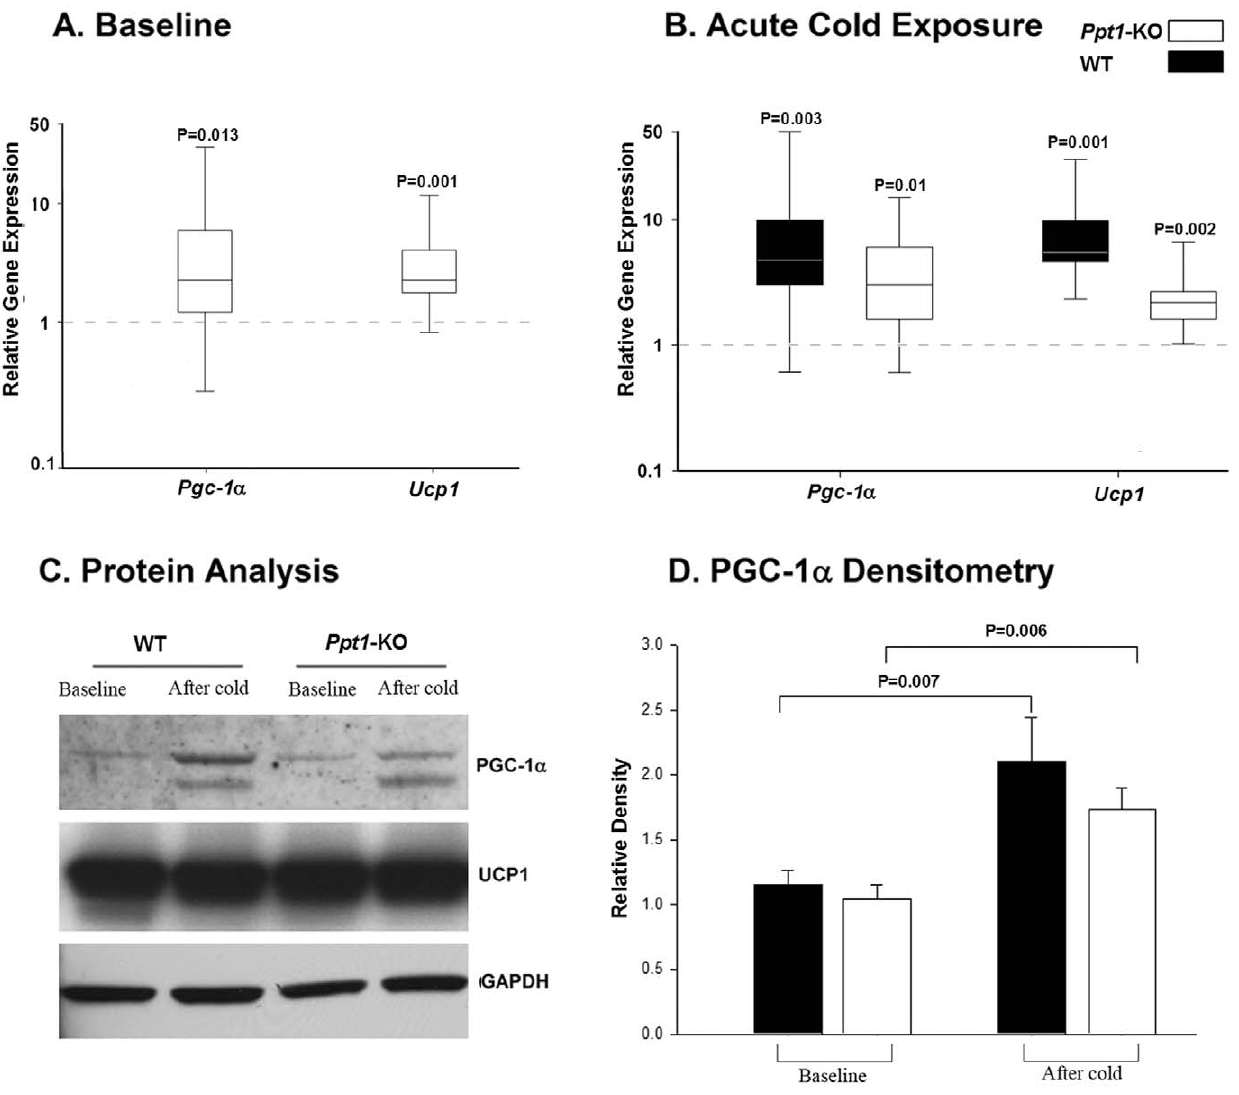
Figure 3. Cold-induced relative expression of Pgc-1 a and Ucp1 in brown adipose tissue Ppt1- KO and wild-type mice. A. Relative Pgc1 a and Ucp1 gene expressions at baseline comparing Ppt1- KO mice and wild-type (calibrator). The expression values for the wild-type controls were arbitrarily set to one for each gene examined and are indicated by the dashed horizontal line. B. Relative Pgc1 a and Ucp1 gene expressions in Ppt1- KO mice and wild-type controls after a six-hour cold (4 u C) challenge compared with respective baseline expressions. The expression values for Ppt1- KO and wild-type mice at baseline were arbitrarily set to one for each gene examined and are indicated by the dashed horizontal line. Relative gene expressions were calculated using REST (cid:2) version 2009 [25]. C. Representative western blots of brown adipose tissue extracts from mice at baseline conditions and after a 6-h cold (4 u C) exposure, probed for PGC-1 a , UCP1 and GAPDH. D. Relative density analysis of PGC-1 a ( + ) bands, normalized to GAPDH levels, expressed in arbitrary units. In all panels, N=4 2 6 for each